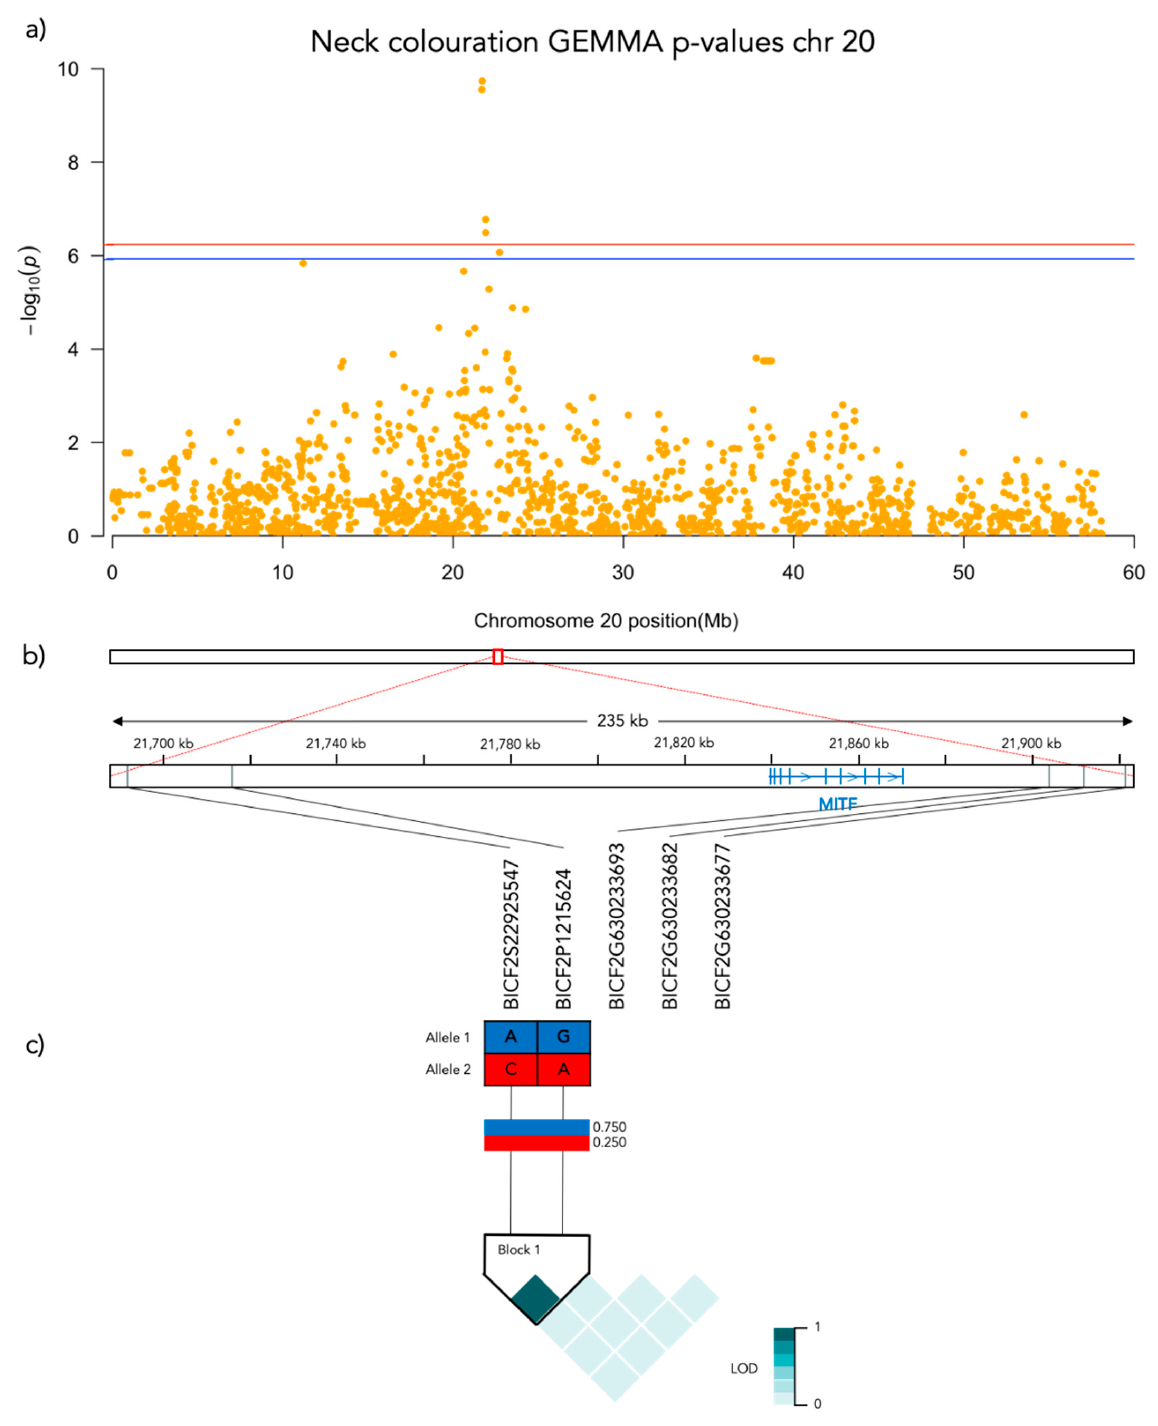
Figure 5. Results from the Genome-Wide Association analysis on the neck coloration phenotype for chromosome 20. ( a ) Manhattan plot of the chromosomes with significantly associated markers. The red line represents genome-wide significance of Bonferroni 5% and the blue 10%. ( b ) (upper) A schematic figure of the size and positioning of the significant region on the chromosome. (lower) Zoomed figure of the associated region showing the positioning of the significant SNP markers in grey and genes in blue. ( c ) Linkage disequilibrium heat map and haplotype blocks of the significant markers.